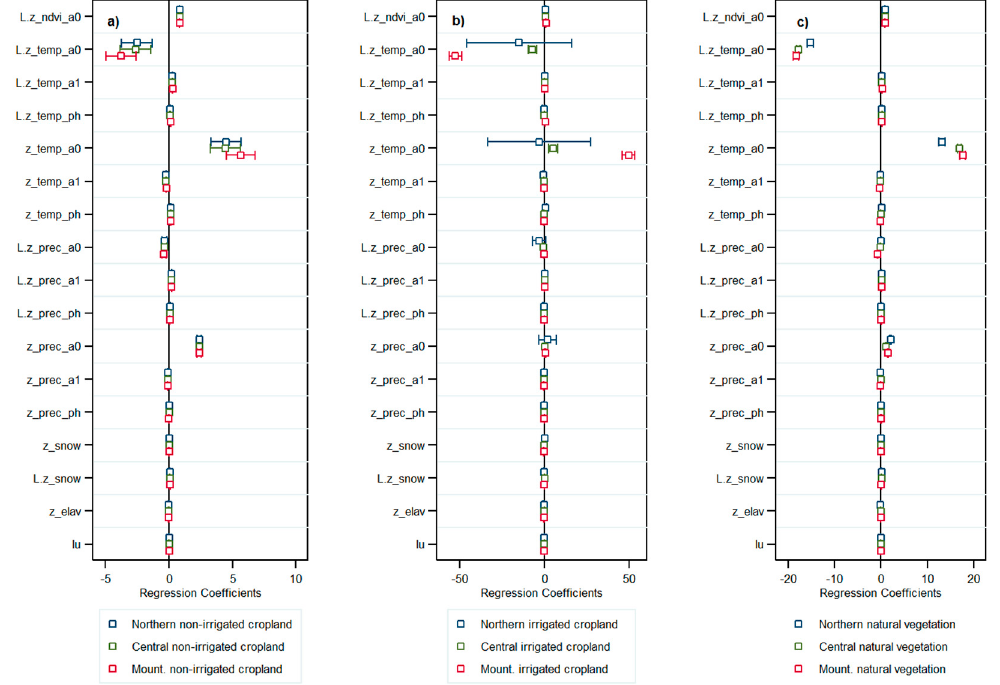
Figure 3. Coefplots of the generalized least-squares random effect models (GLS-RE) models tested to examine relationships between vegetation dynamics and standardized (denoted with “ z ”) environmental factors in the study area: ( a ) Non-irrigated cropland; ( b ) Irrigated cropland; and ( c ) Natural vegetation. The squares represent the variable estimates and the horizontal lines depict 95% confidence intervals. The range of parameter estimates is displayed on the x-axis, and each of the variable labels (Table 1) are displayed on the y-axis. For clarity, a vertical line has been drawn at the zero value.